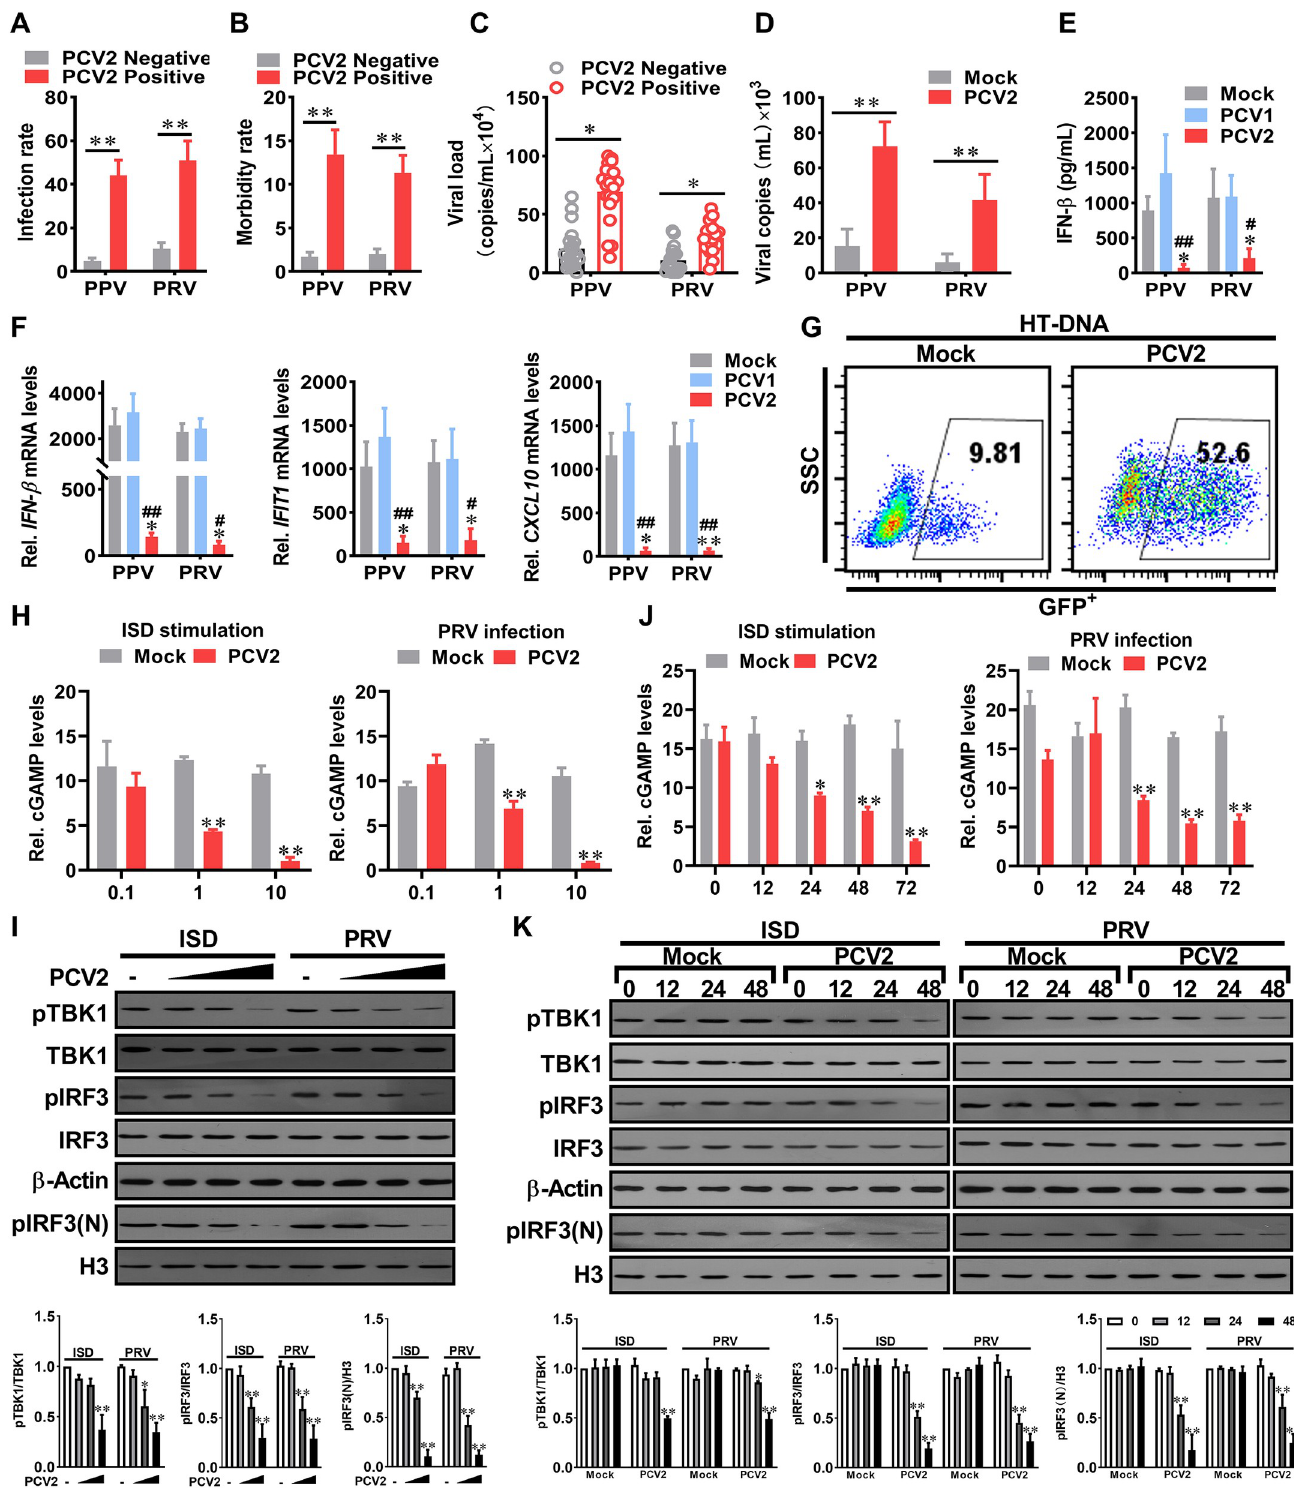
Fig 1. PCV2 inhibits the activation of type I IFN signaling to facilitates the infection of other DNA viruses by reducing cGAMP production. (A, B) The infection rate and morbidity of porcine parvovirus (PPV) or porcine pseudorabies virus (PRV) were compared between PCV2 positive pigs and PCV2 negative pigs. The native pig herds (n = 452) were separated into PCV2 positive group (n = 271) and PCV2 negative group (n = 181), then the infection rates (A) and the morbidity rates (B) of PPV or PRV were further analyzed in these two groups. (C) The PPV and PRV loads in native PCV2 positive pigs are higher than that in